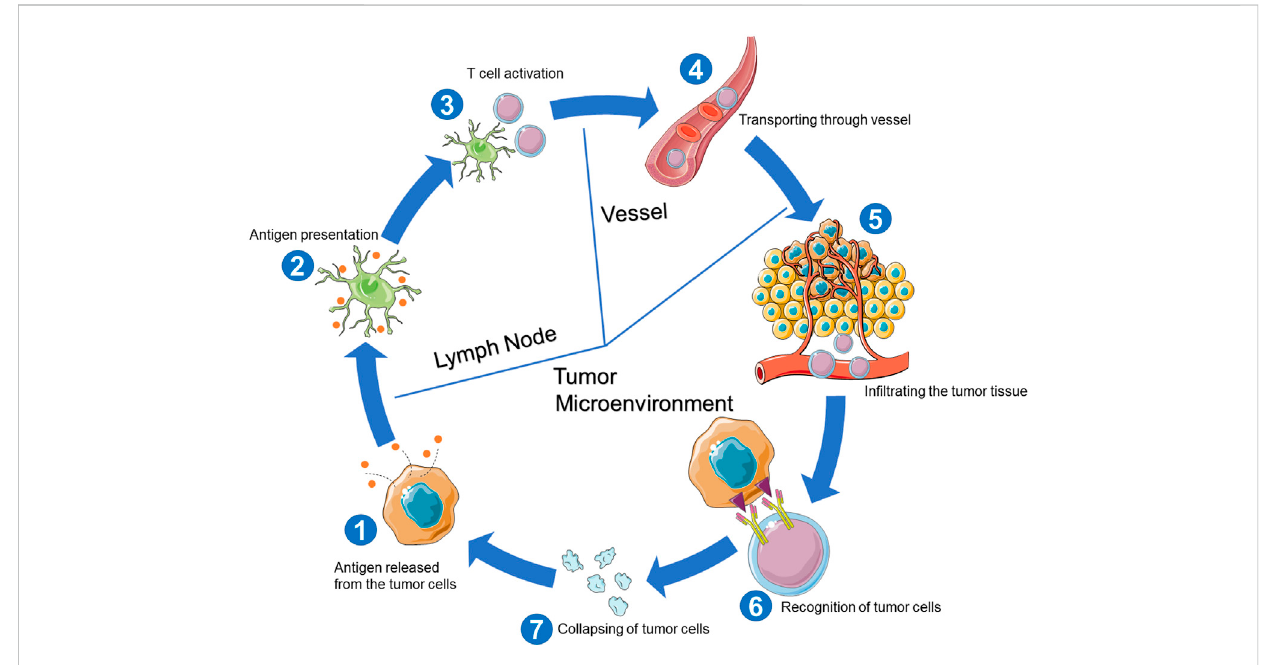
FIGURE 1 Cancer-immunity cycle for killing tumor